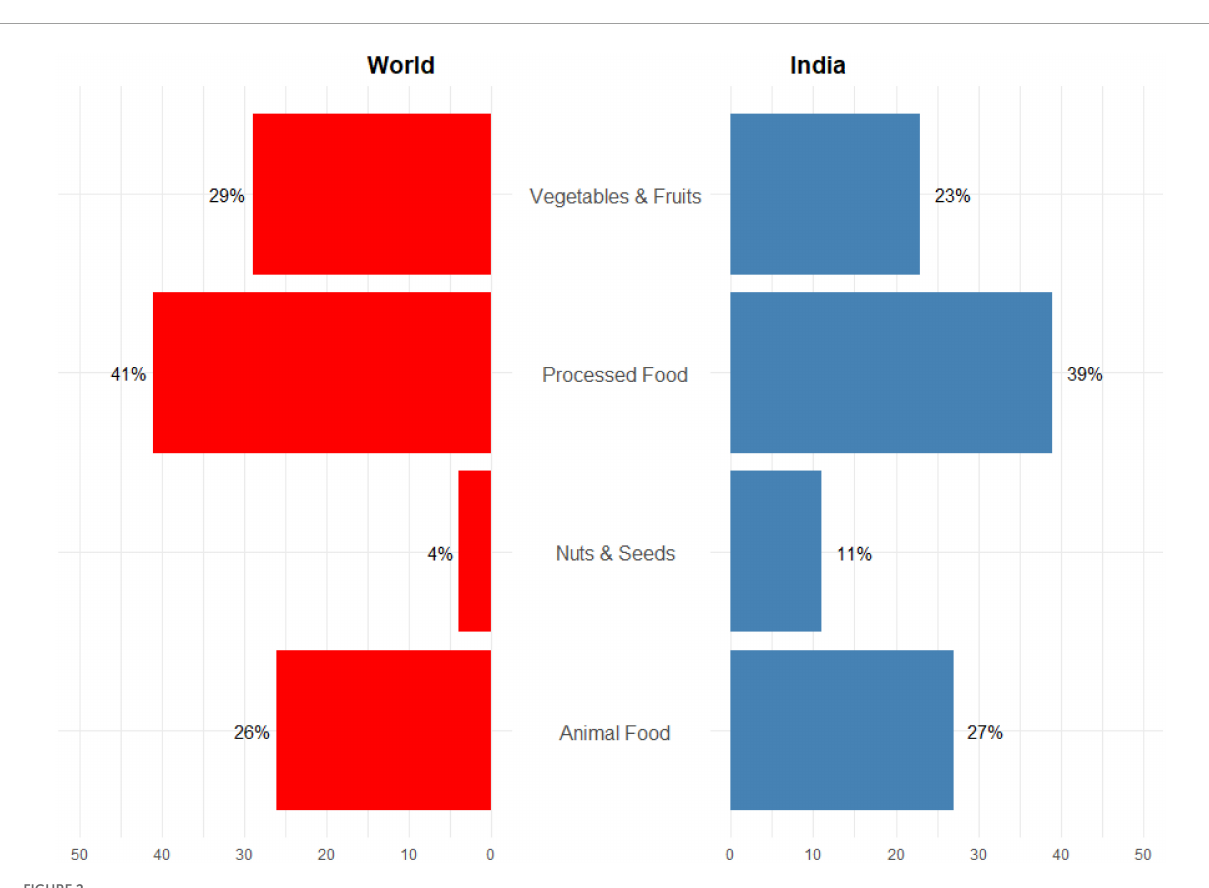
Frontiers in Nutrition